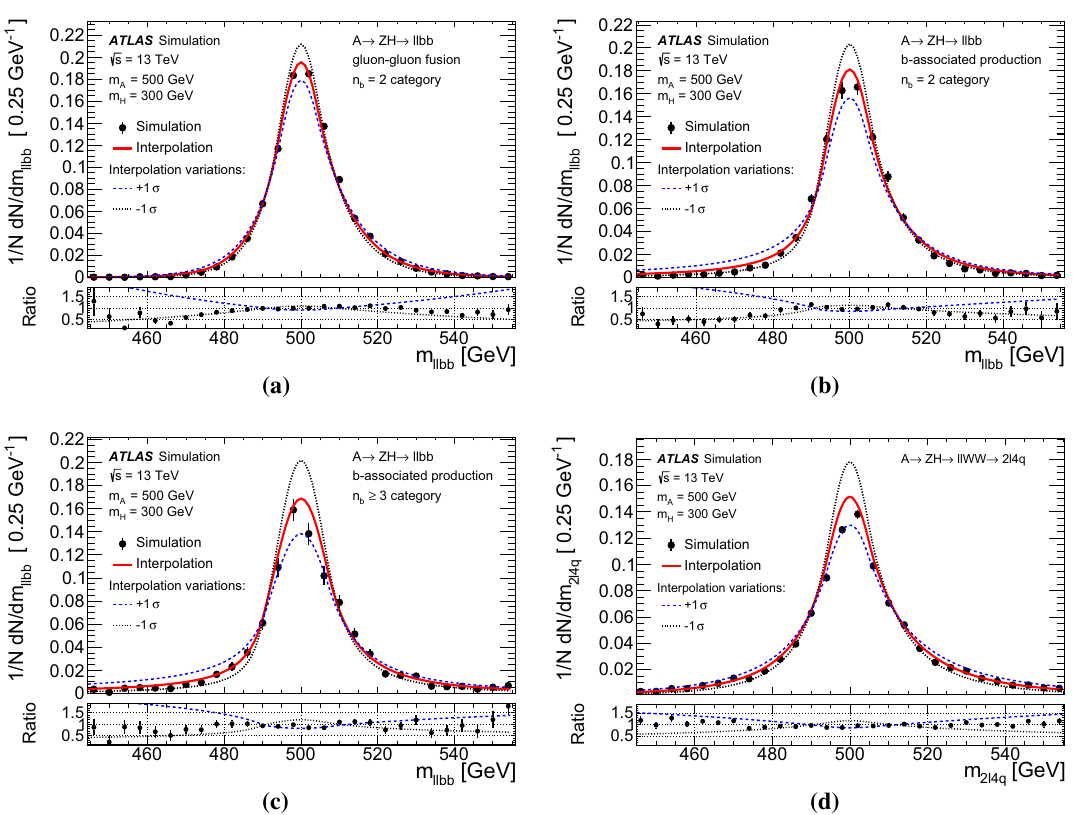
Fig. 6 Signal m (cid:6)(cid:6) bb or m 2 (cid:6) 4 q distributions assuming m A = 500 GeV and m H = 300 GeV for the following cases: (cid:6)(cid:6) bb channel: a gluon– gluon fusion in the n b = 2 category, b b -associated production in the n b = 2 category, and c b -associated production in the n b ≥ 3 cate- gory; d (cid:6)(cid:6) WW channel. In the upper panels, the black filled circles correspond to the simulated distributions, which are compared against the interpolated parameterised signal distributions shown as solid red